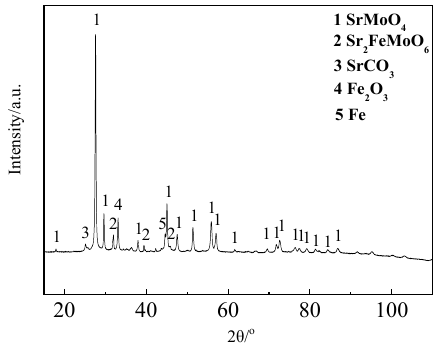
Figure 8 . XRD pattern of the solid sample after degrading